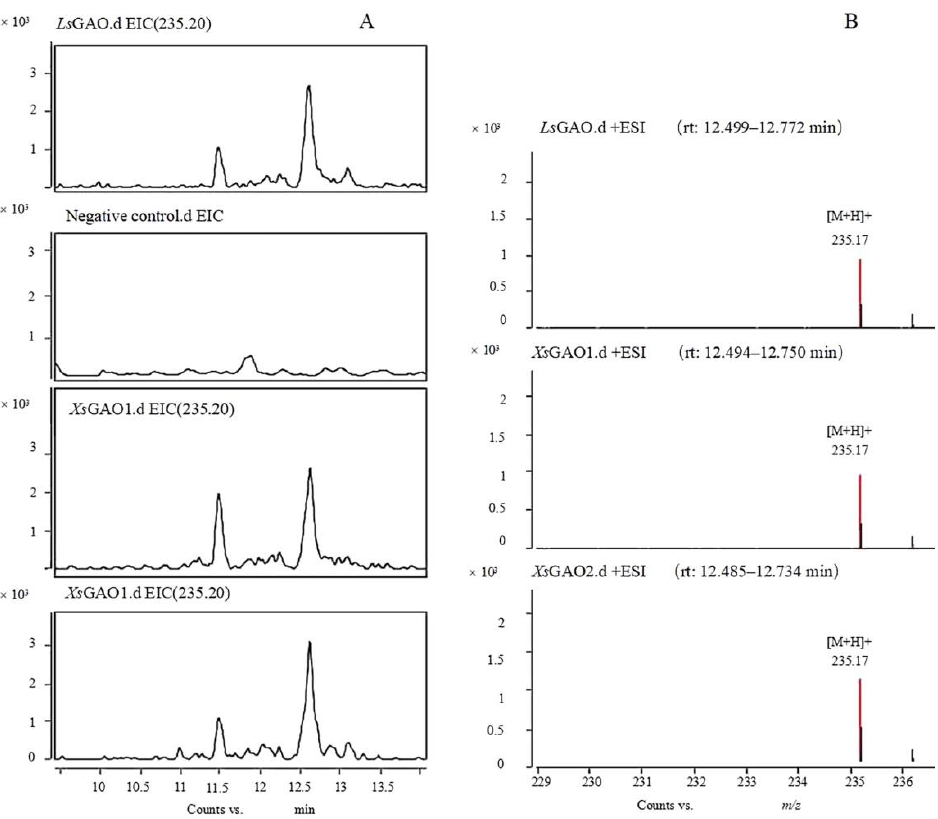
Figure 7. Ls GAO, Xs GAO1, and Xs GAO2 catalyzed germacrene A. ( A ) Renal chromatogram and ( B ) mass spectrum.